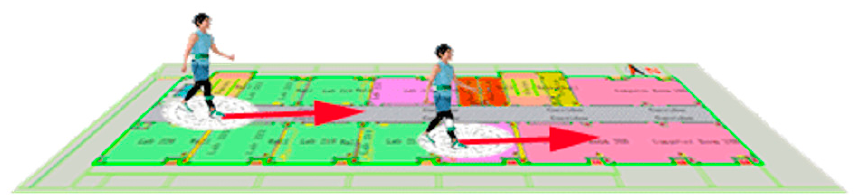
Figure 4. Heading angle calculated strategy with floor map.